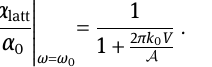
Figure 8: Reflection,transmission,andphase analysis of the meta-membrane in the mid- dle model. Top row: the cavity contains a dispersive atomic medium, but no metasur- face. The reflection and transmission show strong coupling for all modes. Analyzing the argument φ when identifying the denomi- nator of Eq. (22) with − 1 + Ae i φ shows the dispersive medium determining the propa- gation phase. According to Ref. [39], etalon resonances occur as zero crossing of φ , when taking vertical cross cuts at bare- etalon resonant thicknesses. Bottom row: same for a metasurface, and no atomic me- dium. Only every other (symmetric) mode splits.The φ -landscapeismarkedlydifferent from the top row. We assume a dispersive atomic medium with ω 0 (cid:1) 2 . 4 ⋅ 10 15 rad / s, γ (cid:1) 4 ⋅ 10 13 s − 1 and V ⋅ 10 − 27 m 3 inser- atom = 8 ted in α 0 , at density ρ (cid:1) ( 10nm ) − 3 . The metasurface has identical resonance fre- quency and damping as the atomic gas, but with V = 4.8 ⋅ 10 − 24 m 3 and A = (200 nm) 2